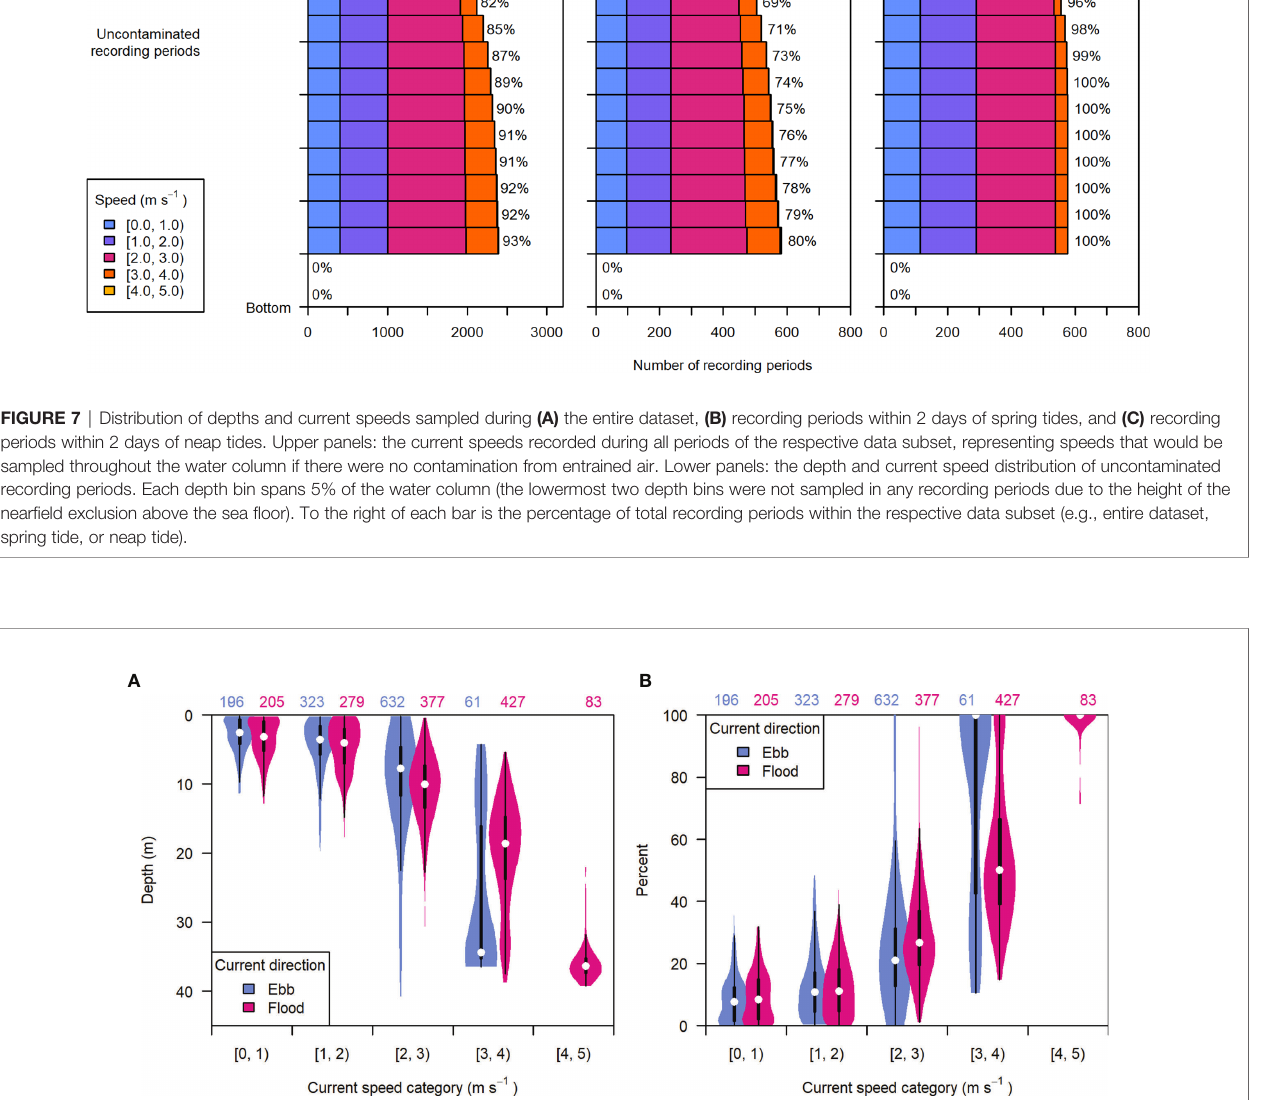
FIGURE 8 | The distribution of (A) entrained air depth and (B) percent of analyzable samples missing from each recording period, grouped by current speed category and tidal current direction (ebb or fl ood). Light blue indicates ebb tide, dark pink indicates fl ood tide. White points are the median value, boxes span the interquartile range (IQR), whiskers extend to 1.5*IQR, and violins span the minimum and maximum values in each group. Numbers at the top indicate the number of recording periods in each